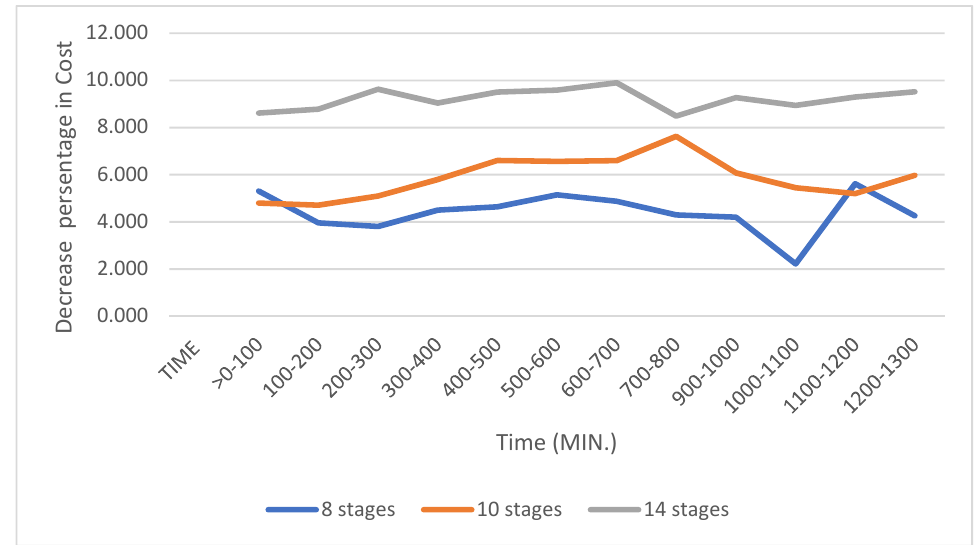
Figure 10. Comparison of the percentage of cost reduction for different stages.